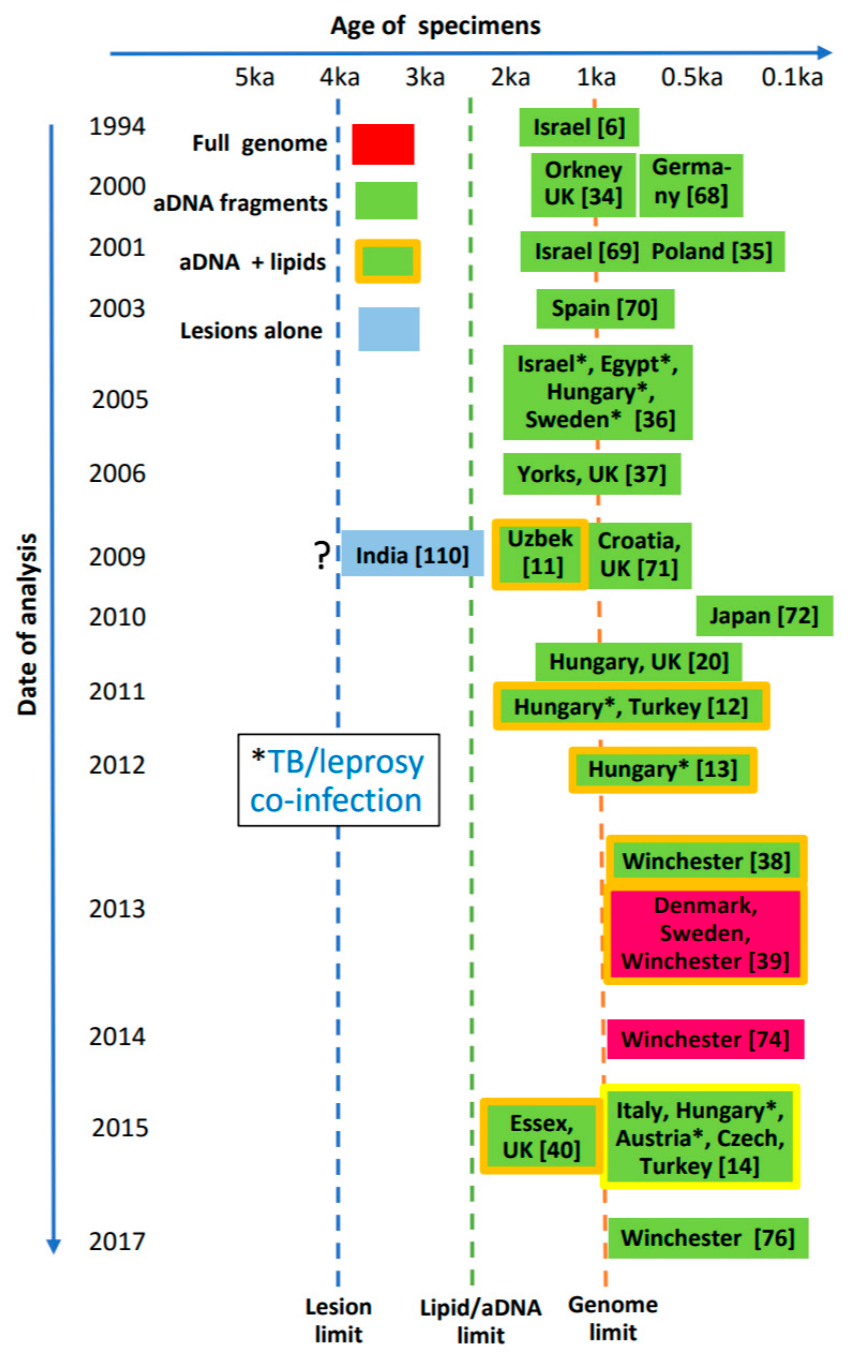
Figure 12. Interrelation of age of suspected ancient leprosy specimens and dates of various analytical investigations. Vertical dotted lines show current limits for diagnostic techniques. The Indian specimen [110] represents the oldest known case with lesions indicative of leprosy, but requires validation.